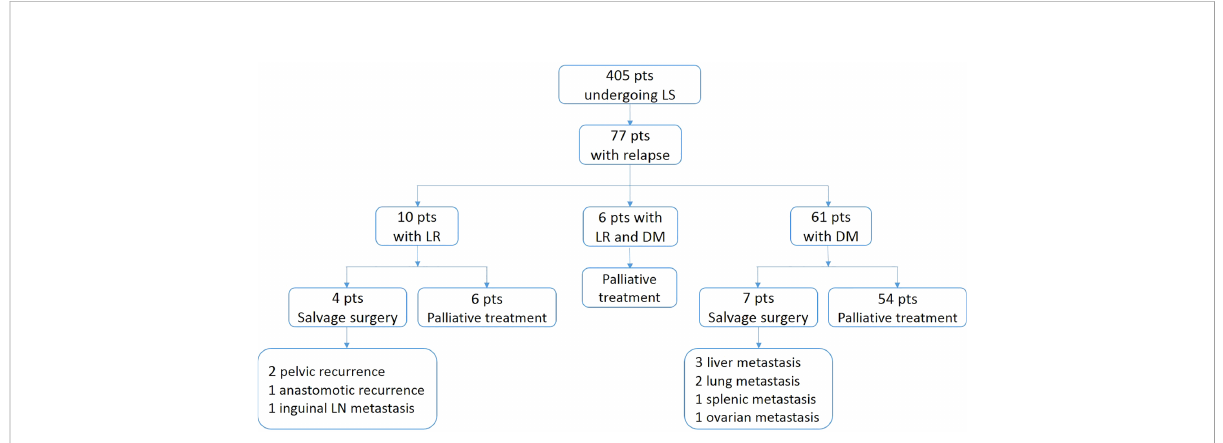
FIGURE 1 Flow diagram of patterns and treatment of patients with relapse. pts, patients; LS, laproscopic surgery; LR, locoregional recurrence; DM, distant